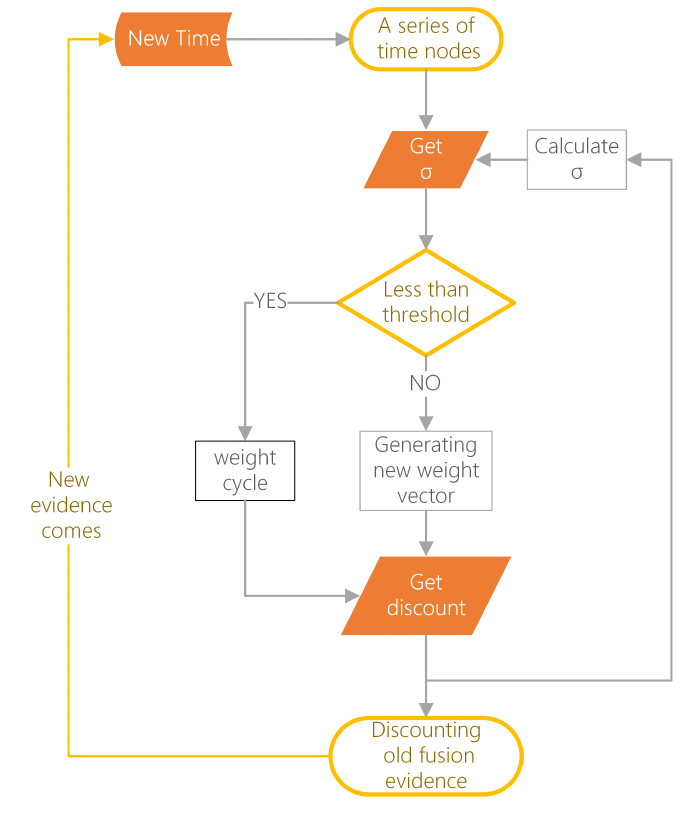
Figure 1. Process to generate OWA